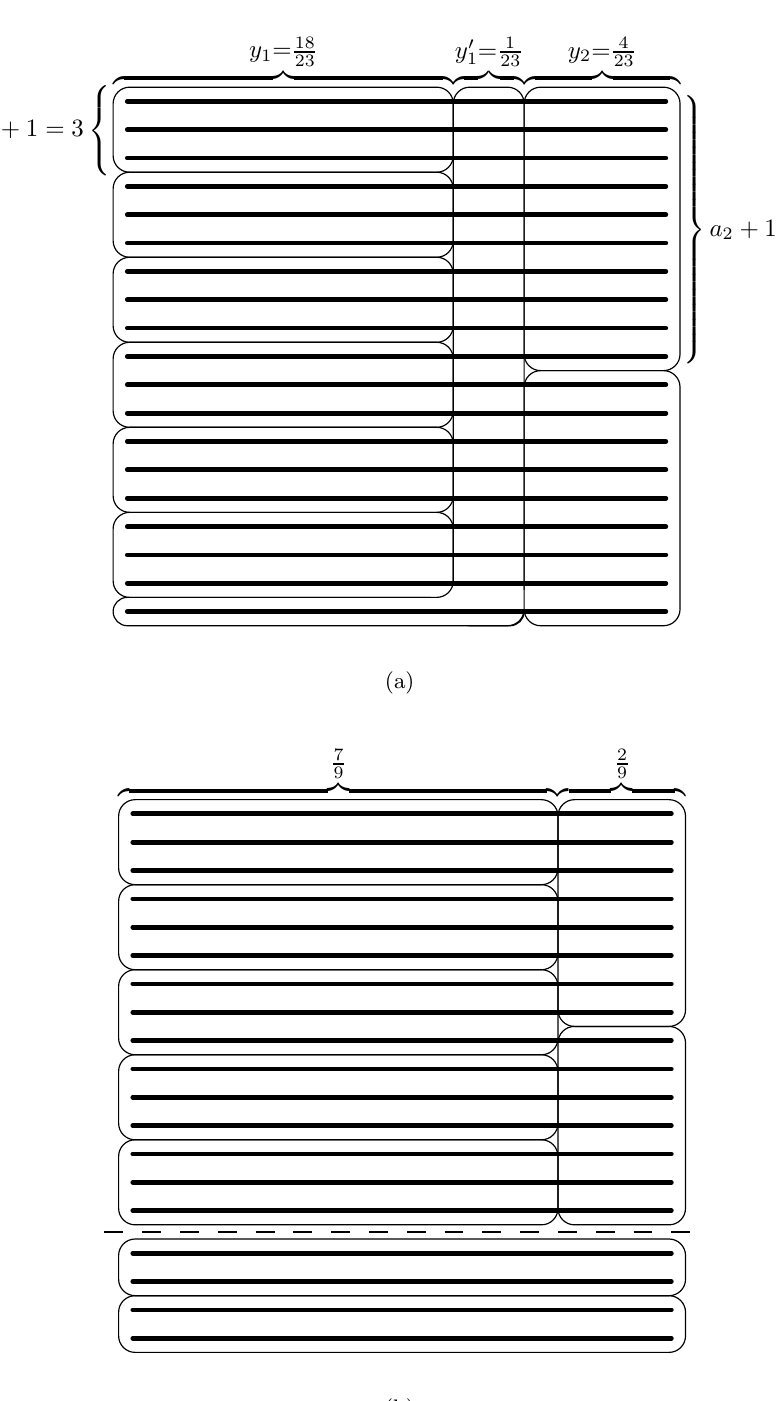
Figure 8: A graphical representation of one of the rare cases, where x = 9 and k = 19 , for which the colouring approach in Algorithm α ( x, k ) may be improved upon sligthly. In (a) the colouring corresponding to Algorithm α ( x, k ) is given with α (9 , 19) = 36 / 23 . A different colouring construction where a “double reduction” is made instead of a balancing subconstruction, is given in (b) resulting in the bound α (9 , 19) ≤ 14 / 9